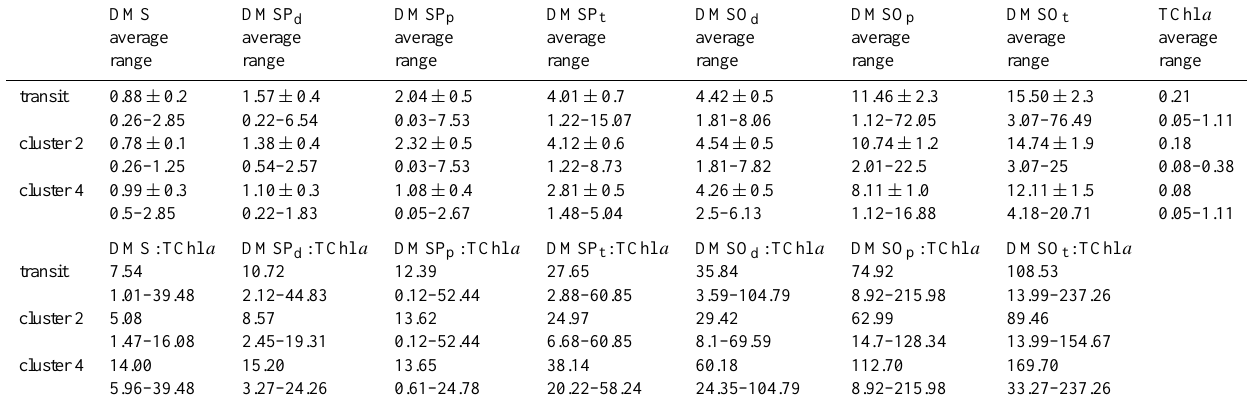
Table 1. DMS, DMSP and DMSO (nmolL − 1 ) and TChl a (mgm − 3 ) concentrations as well as DMS, DMSP and DMSO versus TChl a (nmolmg − 1 ) for the entire transit and for clusters 2 and 4. The errors given in ± present standard deviations calculated according to David (1951). TChl a errors were